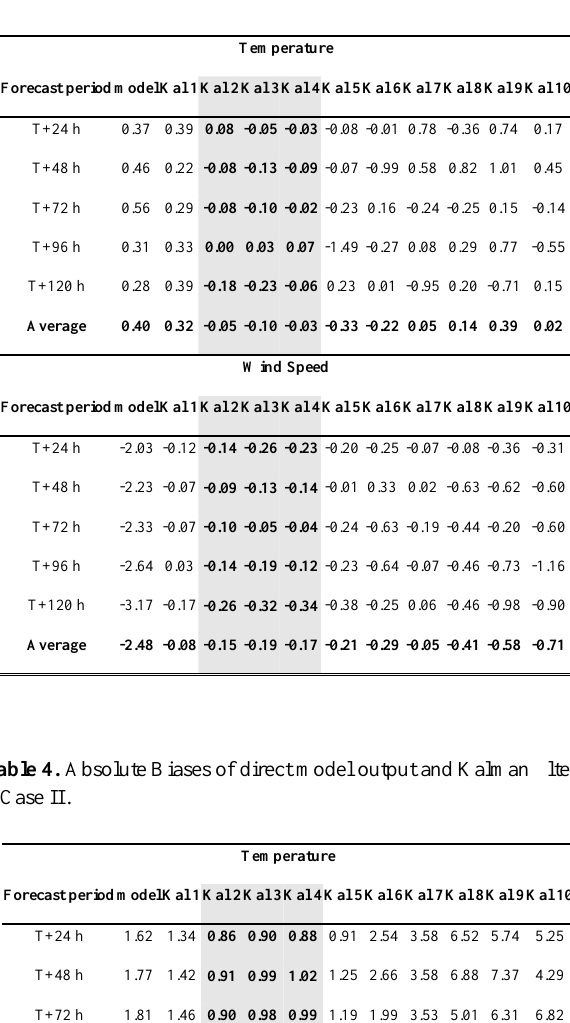
Table 3. Biases of direct model output and Kalman filters – Case II. TABLE 3 . Biases of direct model output and Kalman filters – Case II